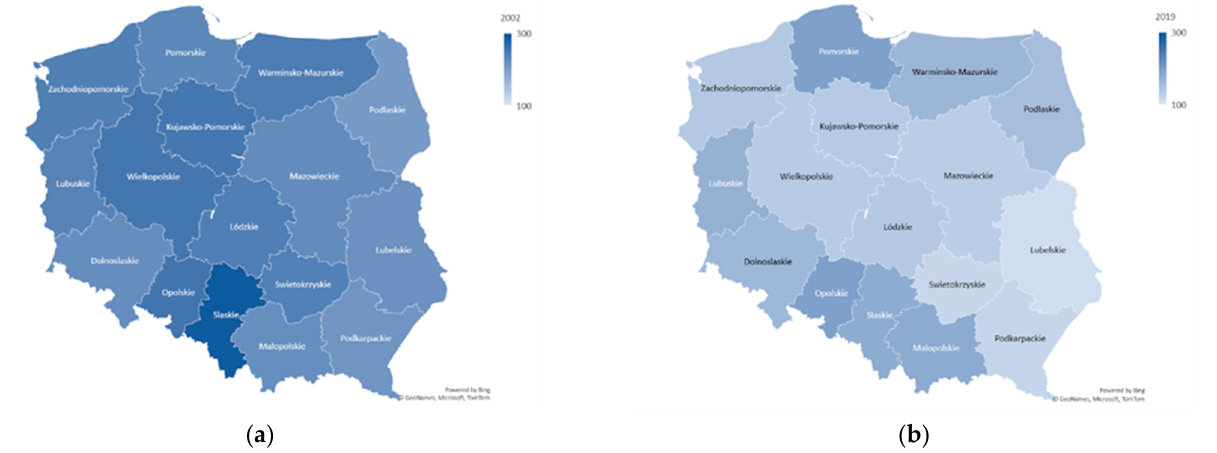
Figure 2. Distribution of amenable mortality rates in Polish regions in 2002 ( a ) and 2019 ( b ).